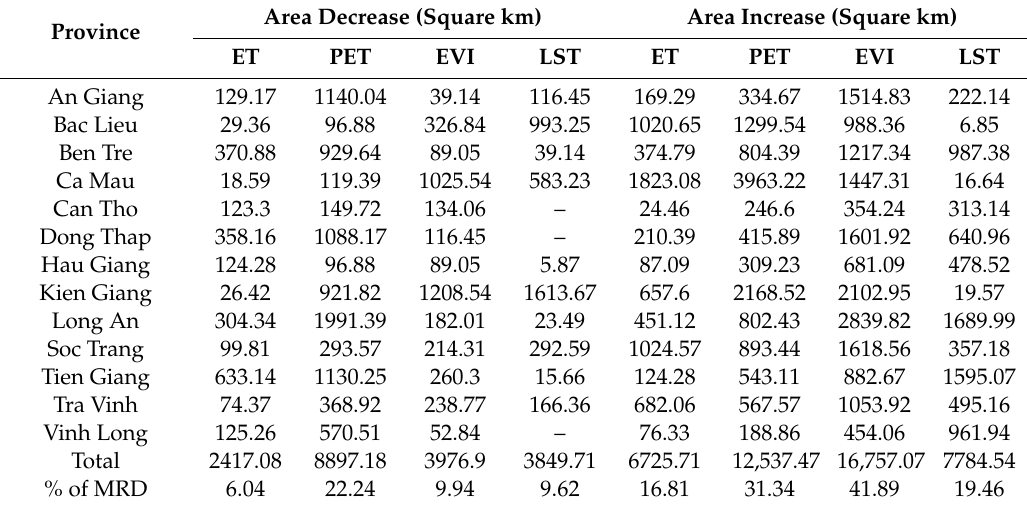
Table 5. Concluding changes of environmental factors in the study area using Theil Sen slope analysis with p <